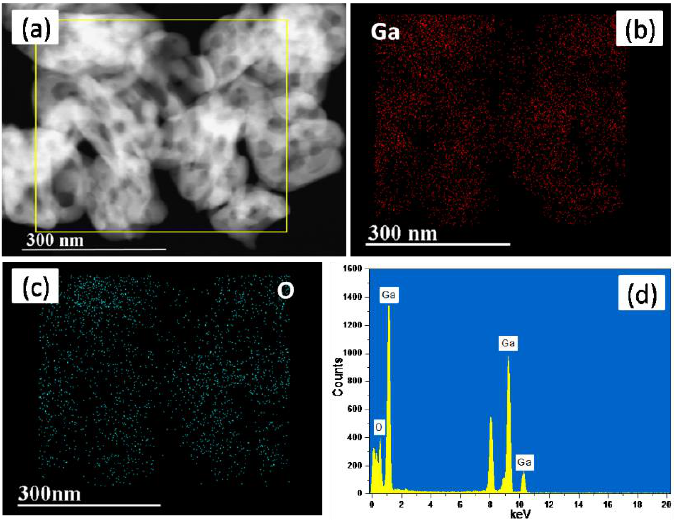
Figure 2. ( a ) Scanning transmission electron microscopy (STEM) image, ( b , c ) energy-dispersive X-ray spectroscopy (EDS) elemental mapping images and ( d ) EDS spectrum of Ga 2 O 3 .